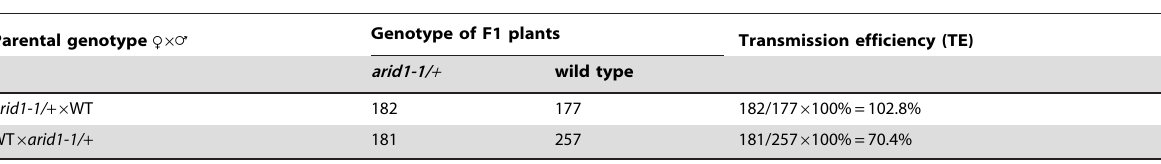
Table 1. Reduced male transmission in arid1-1